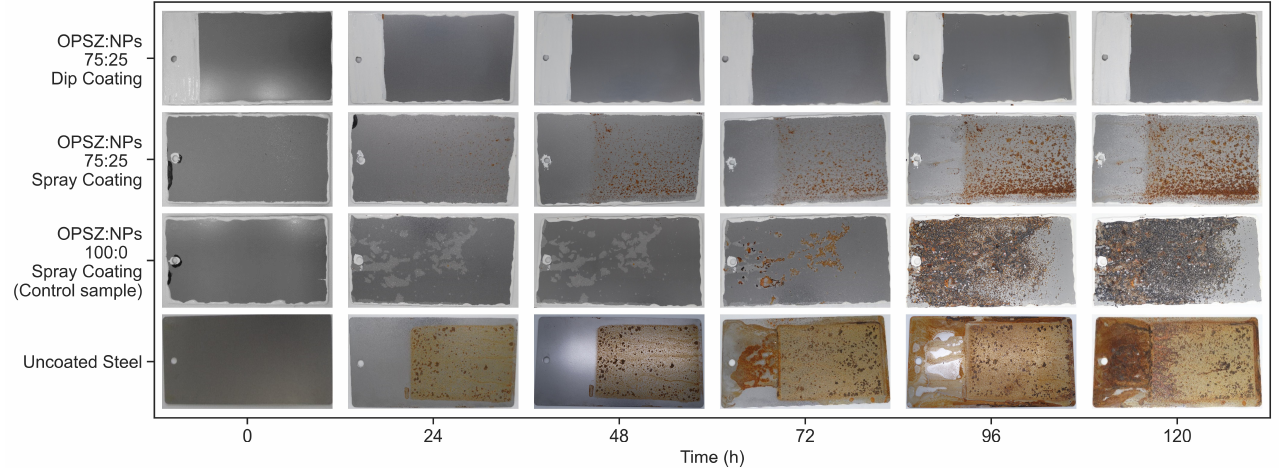
Figure 10. Evolution of coatings on steel during artificial weathering test.